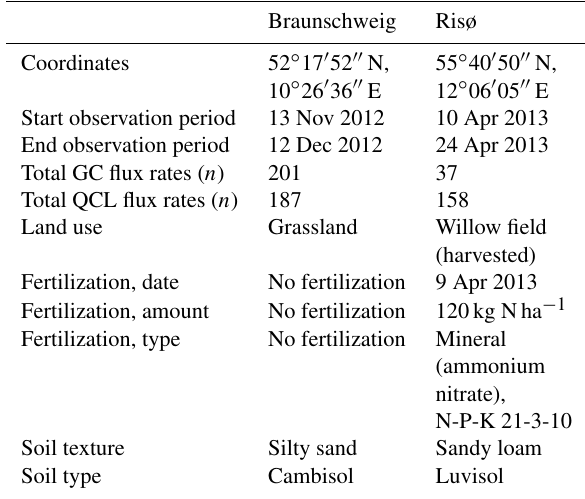
Table 1. Additional information on field